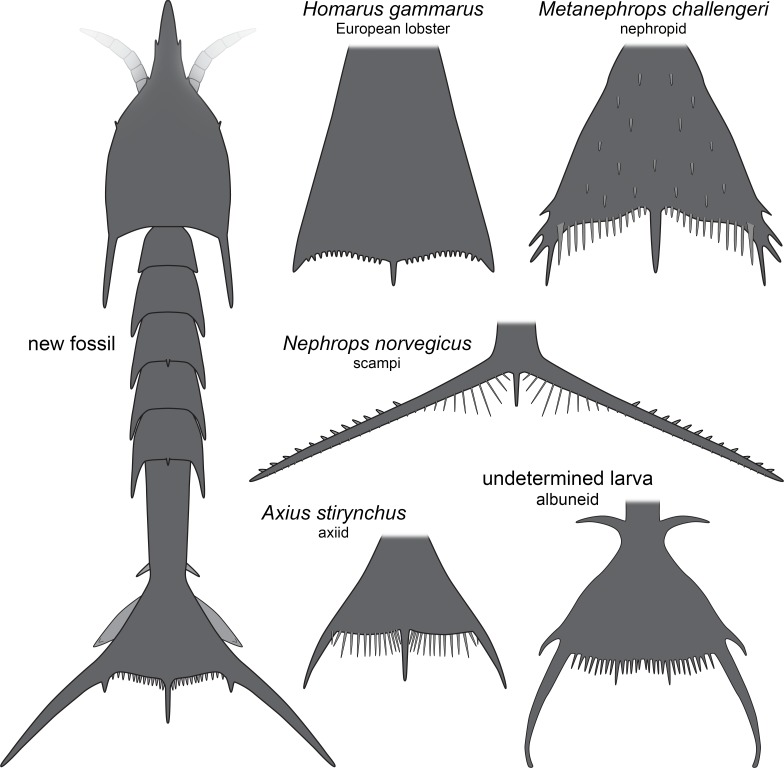
Comparison of the new fossil larva with extant forms.New fossil larva as restoration in dorsal aspect; each of the others as an isolated telson in dorsal view. Homarus gammarus (European lobster); zoea III simplified from Rötzer & Haug (2015). Nephrops norvegicus (scampi, Kaisergranat); zoea III combined from Smith (1987) and Jorgensen (1925). Metanephrops challengeri; late zoea simplified from Wear (1976). Axius stirynchus; late zoea simplified from Dos Santos & González-Gordillo (2004, Fig. 2F). Undetermined albuneid larva; late zoea simplified from Fig. 5.